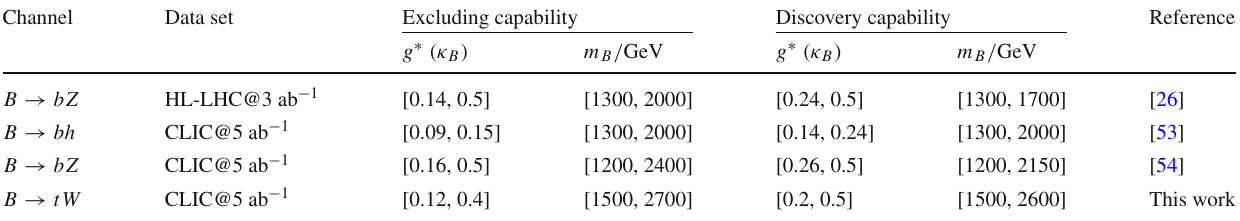
Table 3 Some results of searching for VLQ- B at different colliders Channel Data set Excluding capability Discovery capability